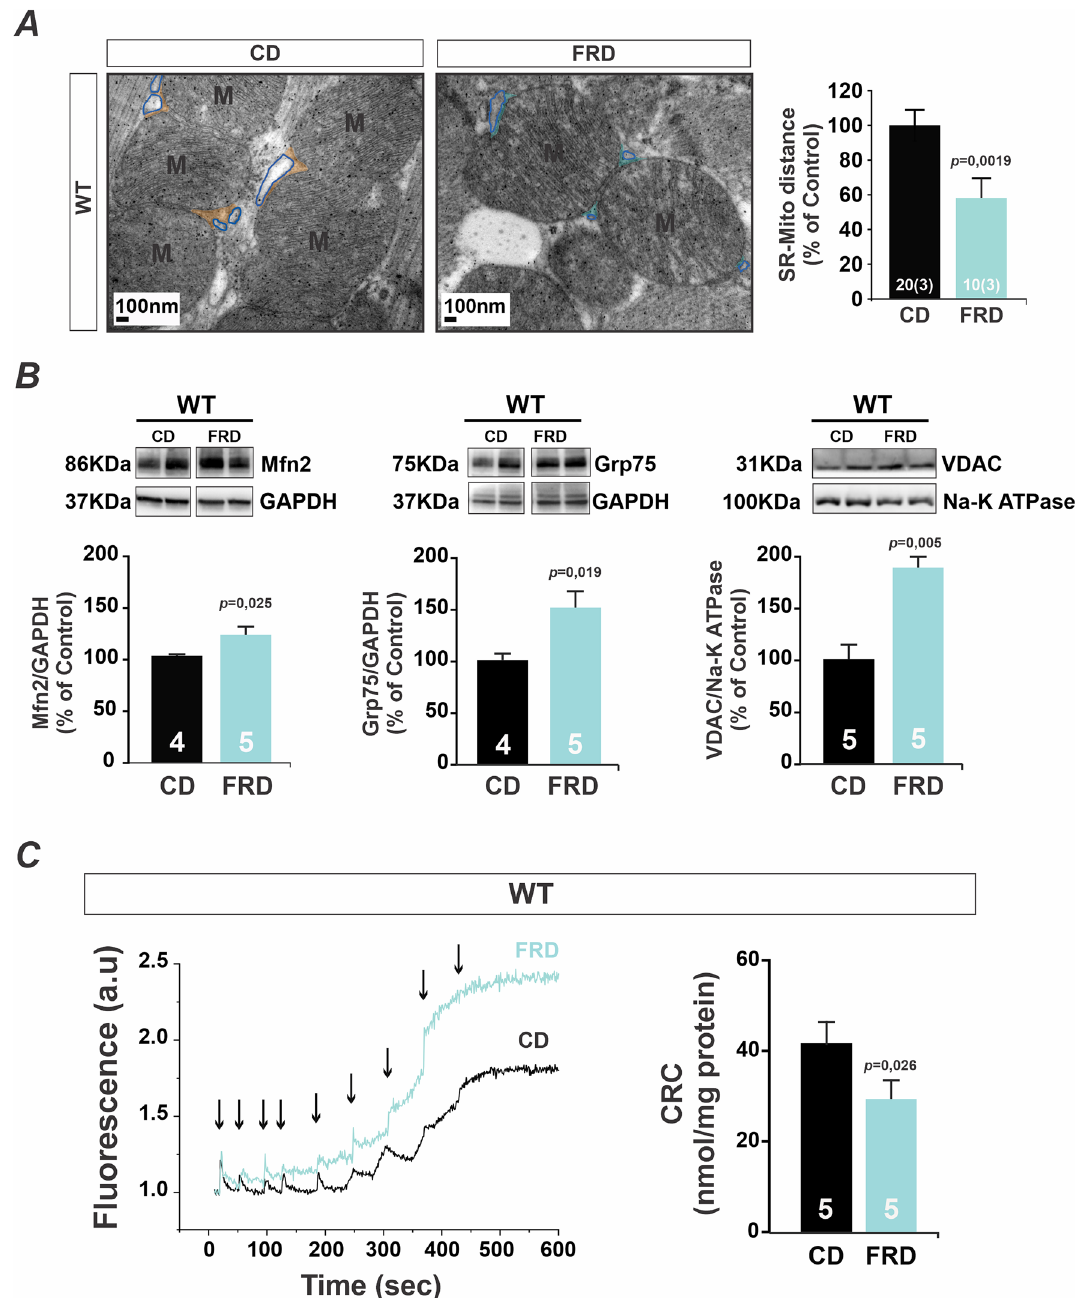
Figure 2. SR-mitochondria increased proximity and enhanced expression of tethering proteins favor mitochondrial Ca 2+ retention capacity. ( A ) Left, representative skeletonized photographs of transmission electron microscopy (TEM) showing SR-mitochondria distance in hearts from CD and FRD WT mice. For the sake of clarity, the SR membrane was skeletonized with a blue line and SR-mitochondria distance was indicated in orange for CD and light blue for FRD WT specimens. On the right, average data of these results. There was a significant decrease in the distance between organelles in FRD with respect to CD WT mice. ( B ) Representatives immunoblots and average data of Mfn2, Grp75, and VDAC expression in CD and FRD WT mice heart. There is an increased expression of the three proteins examined in FRD vs. CD WT mice. ( C ) Ca 2+ retention capacity (CRC) was measured by Calcium Green-5N salt fluorescence on isolated mitochondria suspension and normalized by protein content. Representative fluorescence traces (CD in black and FRD WT in light blue) are shown on the left. Arrows indicate 10µM Ca 2+ pulses added to the suspension. On the right are shown the average data from these experiments. The CRC was calculated as the total Ca 2+ uptake (number of peaks x 10µM) per mg of mitochondria protein. Mitochondria from FRD WT mice heart present a significant decrease in CRC with respect to CD WT